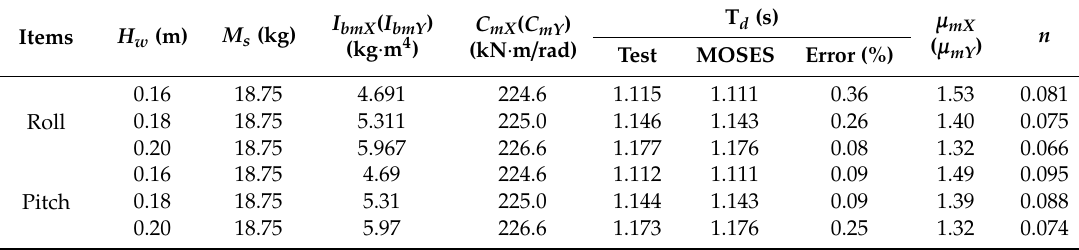
Table 4. Added mass and damping of rocking